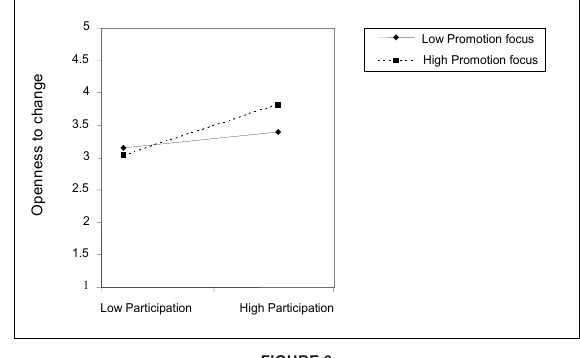
FIGURE 6 Promotion focus moderating the relationship between participation and openness to change in sample 1